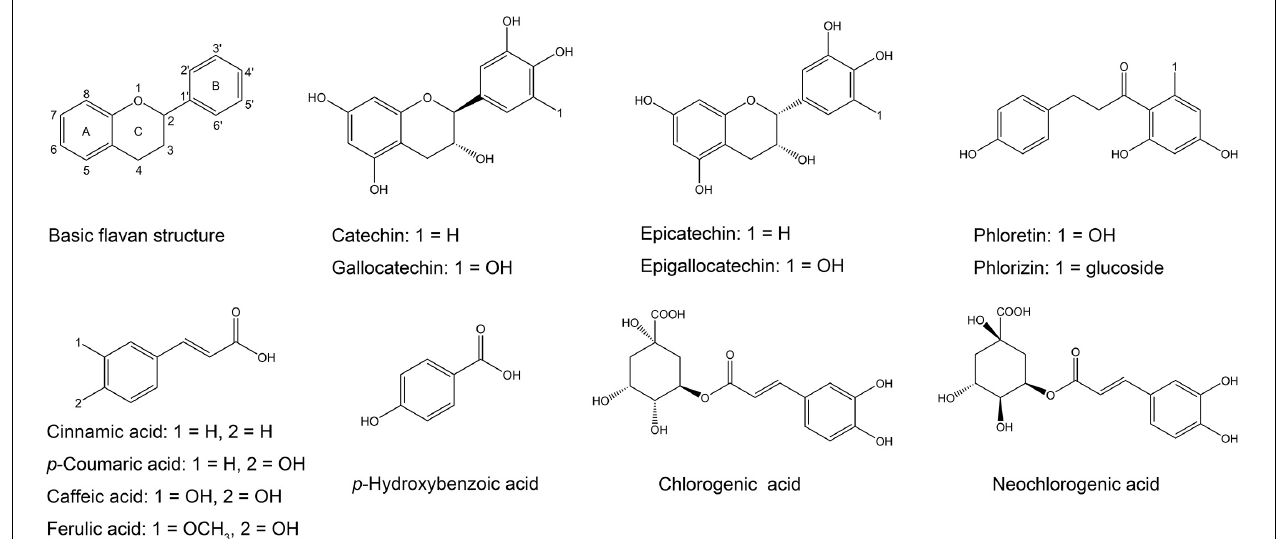
FIGURE 5 | Chemical structures of phenolic